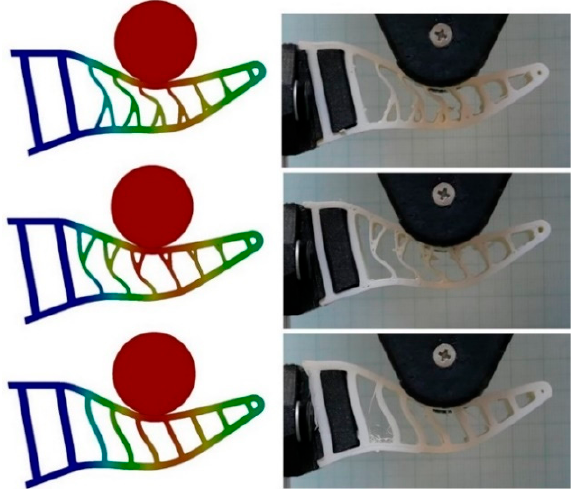
Figure 15. Comparison of the simulation with the printed tested finger, left: simulation, right: real test; top: structure E mark EO0808, middle: structure E mark EC0808, bottom: structure A with the number of ribs 6.